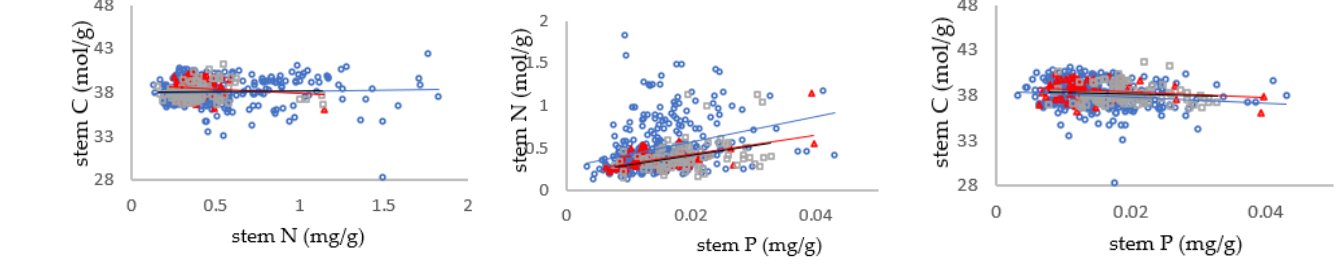
Figure 3. The relationship between the ratio of C, N, and P in stems for different mycorrhizal types. The blue cycles and blue lines mean AM, the red triangles and red lines mean AM + ECM, and the gray squares and black lines mean ECM.